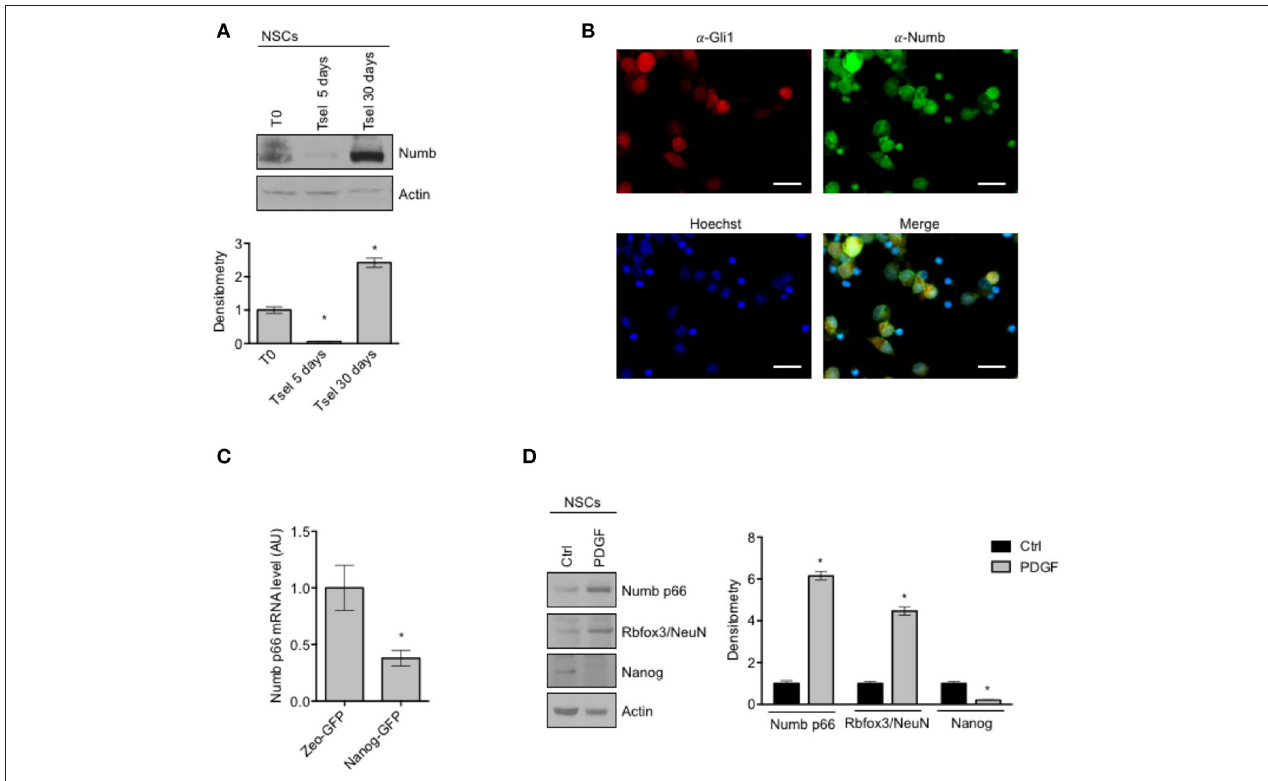
FIGURE 1 | Numb expression in NSCs. (A) Representative Western Blot (WB) (up) and densitometric analysis (bottom) of endogenous Numb isoforms (p66 and p72) in NSCs grown in selective medium for 5 or 30 days, compared to bulk cells (T0). Actin was used as loading control. P -values * p < 0.05. (B) Representative images of immunofluorescence staining of NSCs for Numb (green) and Gli1 (red); nuclei are counterstained with Hoechst (blue). Scale bar: 10 µ m for all panels. (C) qRT-PCR analysis showed mRNA expression of Numb p66, evaluated in NSCs infected with lentivirus carrying Nanog-GFP or Zeo-GFP as control and sorted for GFP. Data represent means ± SD from three independent experiments. P -values * p < 0.05. (D) Representative Western Blot (WB) (left) and densitometric analysis (right) of NSCs before and after in vitro differentiation for 48h (PDGF); p66, Rbfox3/NeuN, Nanog were evaluated. Actin was used as loading control. P -values * p < 0.05. (A–D) Data are means ± SD from three independent experiments. Full-length images are presented in Supplementary Figures